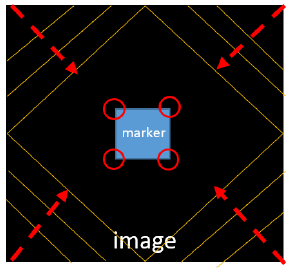
Figure3. The concept of corner detection